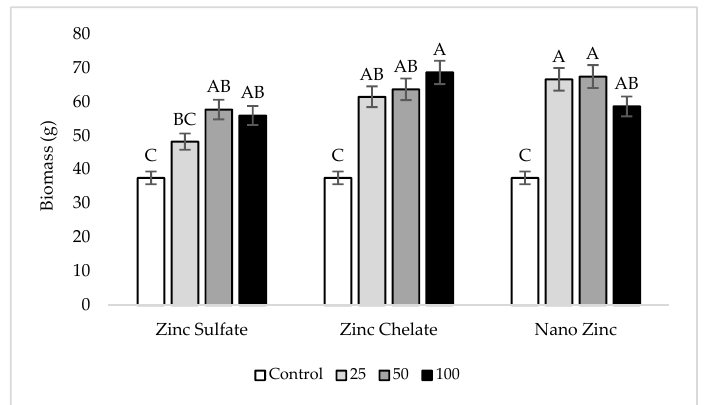
Figure 4. Effect of applying nanofertilizers, chelates, and zinc sulfates to the total biomass of green beans cv. Strike. Letters show significant differences.